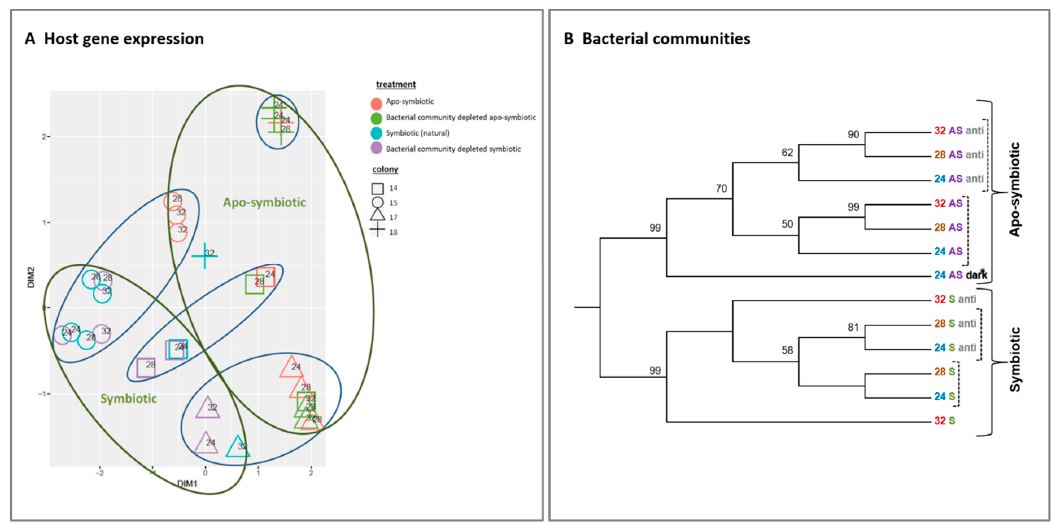
Figure 2. Host gene expression and bacterial communities clustering by symbiotic and apo ‐ symbiotic E. paradivisa samples (12 treatments). ( A ) Multi ‐ dimensional scaling (MDS) clustering of 29 tested samples (15 symbiotic and 14 apo ‐ symbiotic; see Table S2). Colony origin is indicated by a distinctive shape, the preliminary treatment by a colour (see legend), and the temperature is indicated within the figure. Clusters formed according to apo/symbiotic state are marked with green circles, and clusters formed according to colony origin are marked with blue circles. ( B ) Cluster analysis of microbial community 16S rRNA NGS libraries ( n = 289,579) generated from 13 E. paradivisa samples (12 treatment including one group “24 AS dark*” as control, see below and Table S1)). An unrooted neighbour ‐ joining tree of communities by 16S rRNA gene NGS. Bootstrap values represent 100 iterations. Sequences retrieved were analysed using MOTHUR software [40]. The curly brackets indicate the main cluster segregation by symbiotic and apo ‐ symbiotic types, while the dashed brackets indicate an inner subdivision by antibiotic treatment. The sample “24 AS dark*” represents apo ‐ symbiotic polyps that were kept in the dark as control. Labels are coloured according to temperature treatment and symbiotic state type.